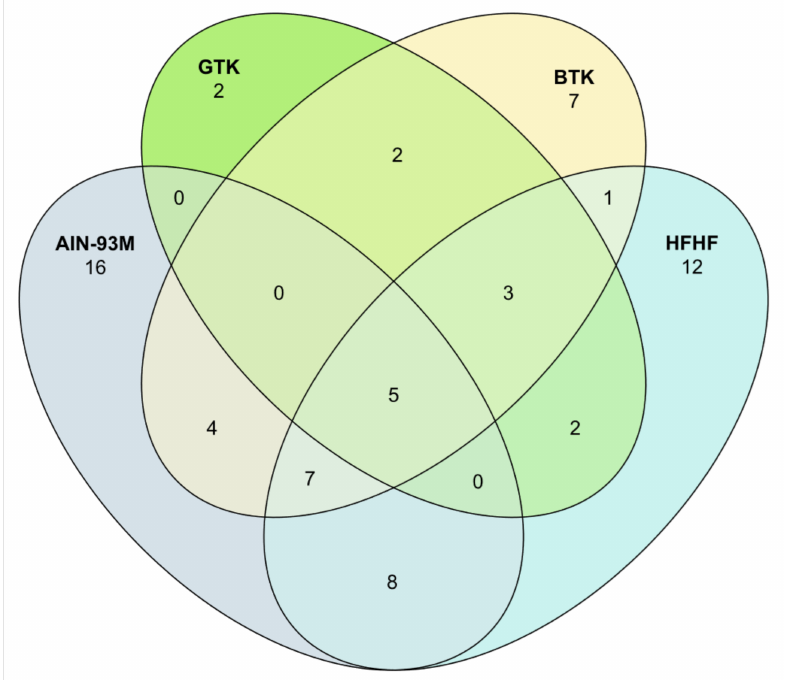
Figure 7. Venn diagram representing shared amplicon sequence variants (ASVs) of the core micro- biome identified in the groups AIN-93M, GTK, BTK, and